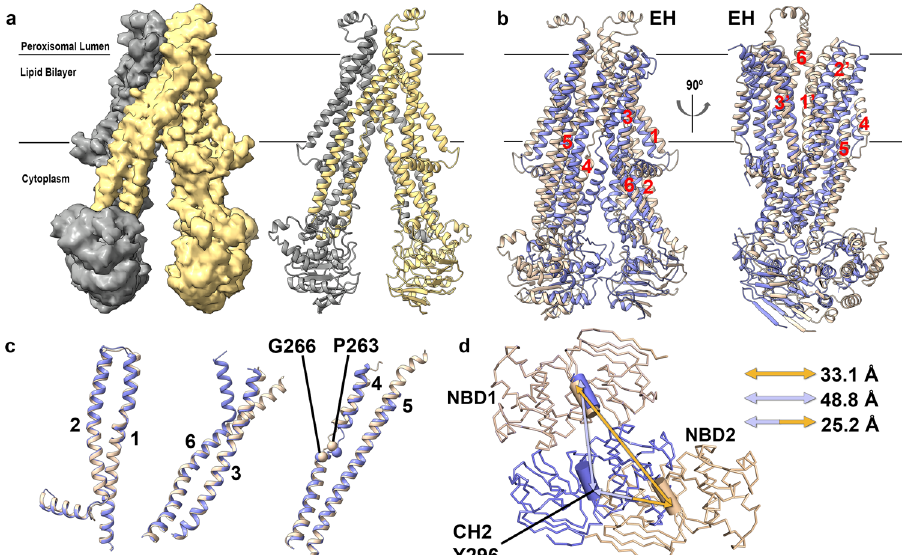
Fig. 2 Comparison of IO and OO conformations of ABCD1. a EM density map (0.04 contour) of human ABCD1 IO (cytoplasm facing) conformation colored yellow and gray for two monomers with similarly colored ribbon representing the protein backbone at right. b All C α -atom overlay of IO and OO structures of human ABCD1 (gold and blue ribbons, respectively) with TMs numbered and external helix (EH) shown for IO conformation, with far viewing plane clipped to 10 Å. c Superposition of individual TM pairs from IO and OO structures with TM4 disrupting P263 & G266. d Comparison of NBDs of IO and OO structures aligned using NBD1 as reference from the lumenal viewpoint. Arrows depict inter coupling helix 2 (CH2) distances between Y296 C α